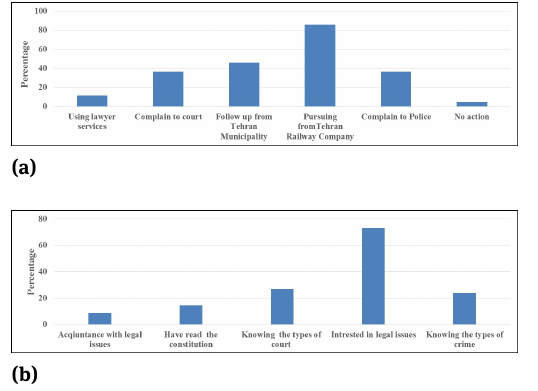
Figure 11: Characteristics of investigated statistical population, (a) actions taken against SBN/SBV and (b) legal information about SBN/SBV.